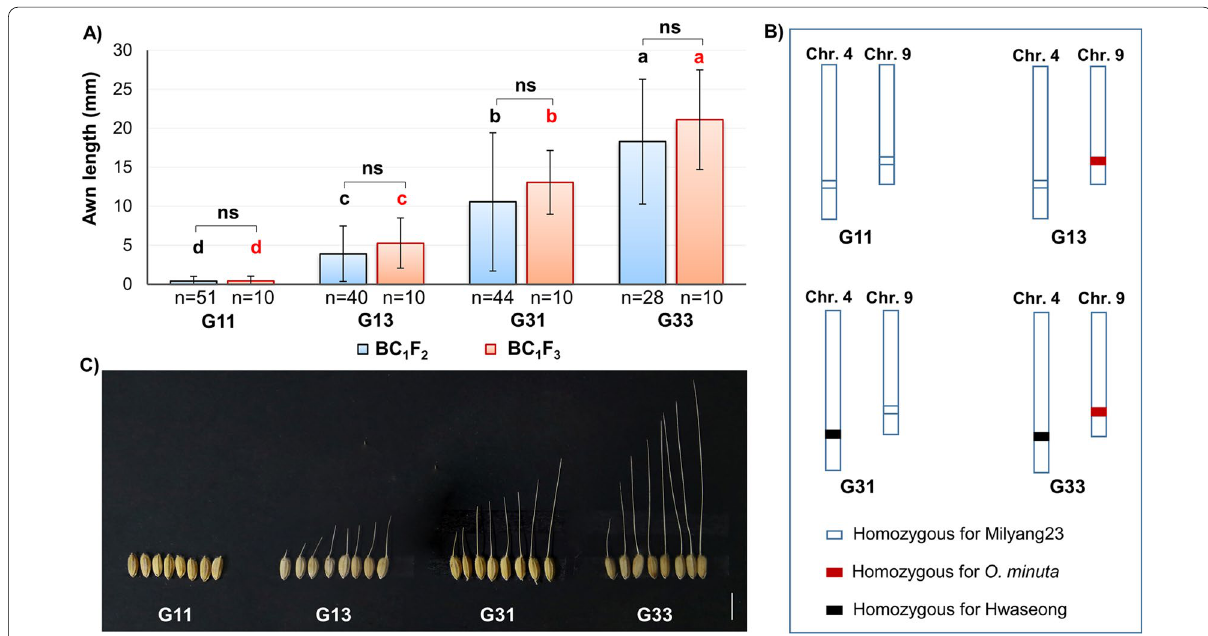
Fig. 4 Comparison of awn length of the four genotype groups in BC 1 F 2 and BC 1 F 3 generations. A Means labeled with different letters are significantly different among genotypes (Tukey’s test, p < 0.05). The error bar indicates the standard deviation. B Graphical genotypes of four genotype groups. C The photograph shows variations in awn length of four genotype groups. Scale bar